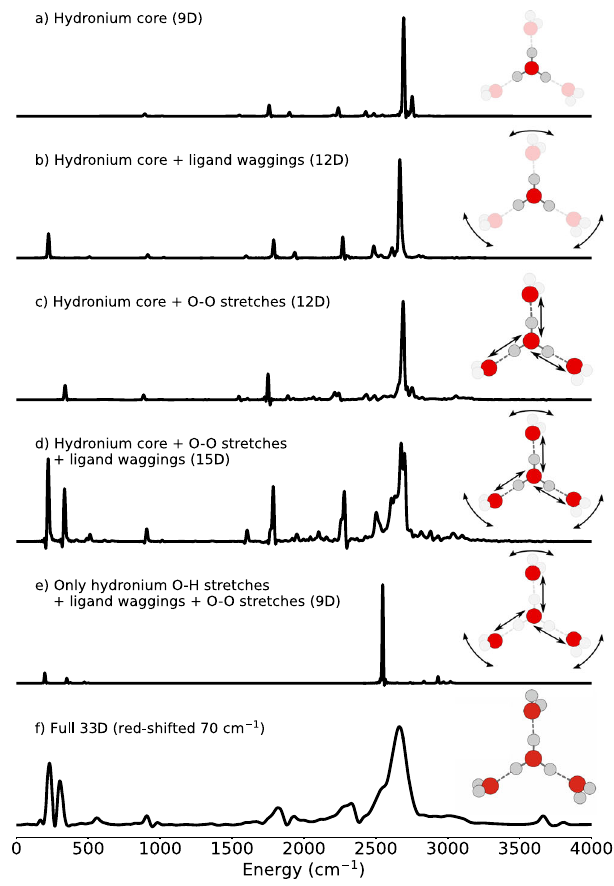
Fig. 2 | Spectra obtained with the z-component of the dipole moment (cf. Eq. (2)) for various reduced models. The dimensionality (9D, 12D etc.) denotes the number of active coordinates. Other coordinates are frozen to their expectation value positions for the vibrational ground state. Correlation time in a – e : 2000fs, ( f ): 1000fs. Source data are provided under https://doi.org/10.5281/zenodo.